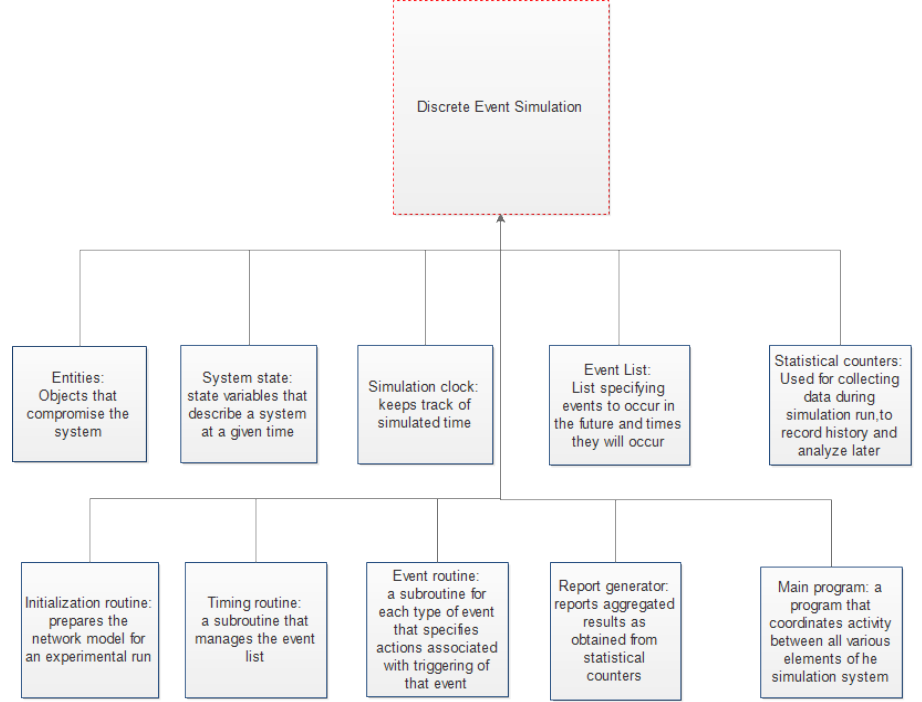
Figure 1. Elements of discrete-event simulation .